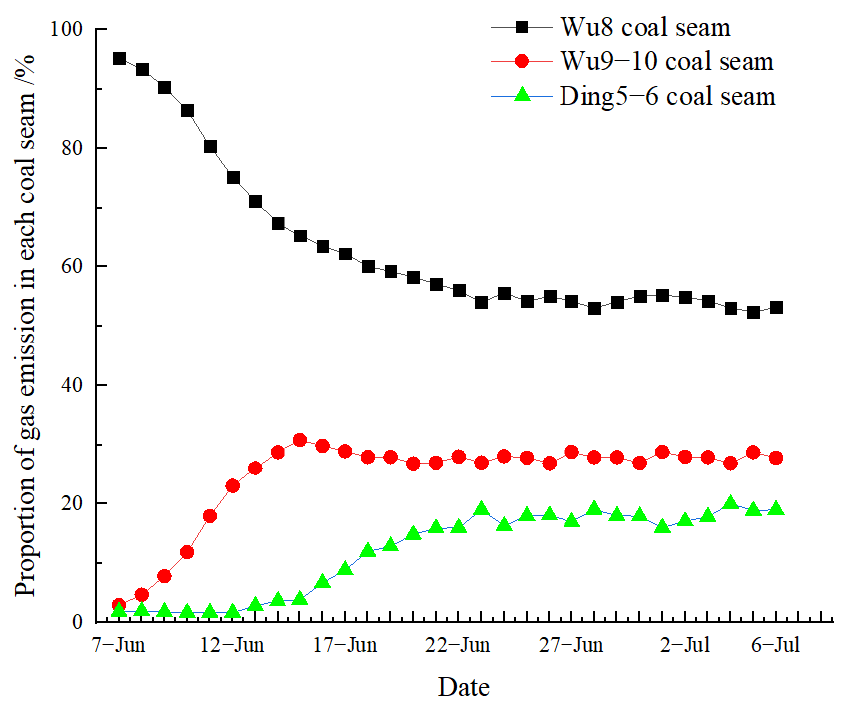
Figure 6. Gas emission proportion of each coal seam in goaf.